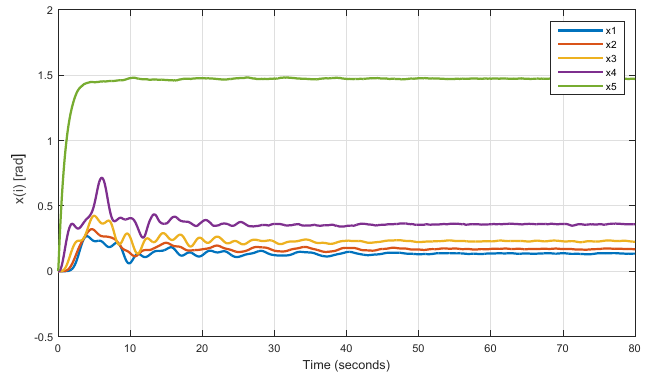
Figure 5. Output angles of the flexible bar.